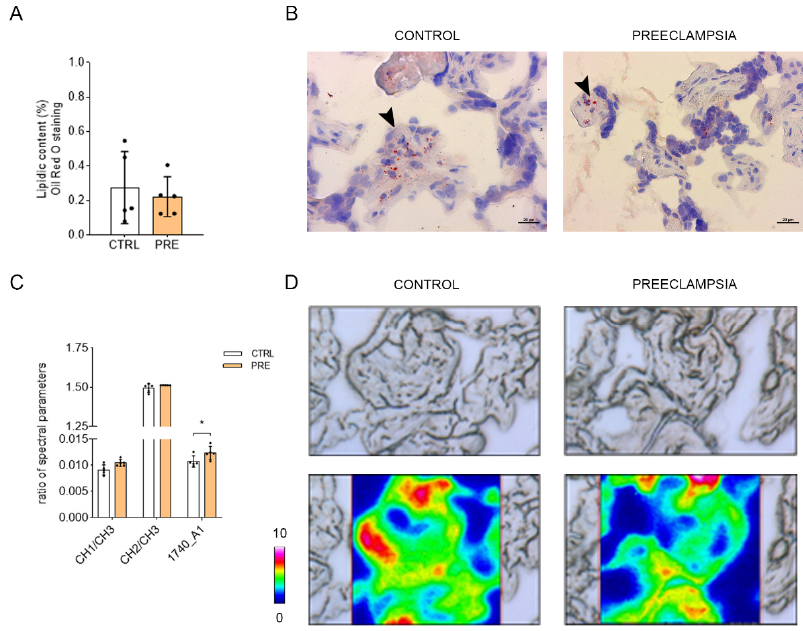
Figure 6. Histological and FTIRI analysis of lipids in the two experimental groups. Analysis of lipid content in CV section using oil red O staining ( A , B ). Bars represent lipid content in the two condi- tions expressed as mean ± SD of five independent samples ( n = 5). Histological microphotographs show the lipid droplets stained in red (arrowhead) inside the CV. Analysis of lipid content and peroxidation in CV section by means of FTIRI ( C , D ). Bars represent the ratio between the following spectral parameters: CH2/CH3, length of lipid alkyl chains; CH/CH3, unsaturation degree in lipid alkyl chains; 1740/AI, ester groups in lipid alkyl chains. Results are reported as mean ± SD of five independent samples ( n = 5), and asterisks indicate significant differences between CTRL and PRE groups (* = p < 0.05). False-color images showed the topographical distribution of lipids within the